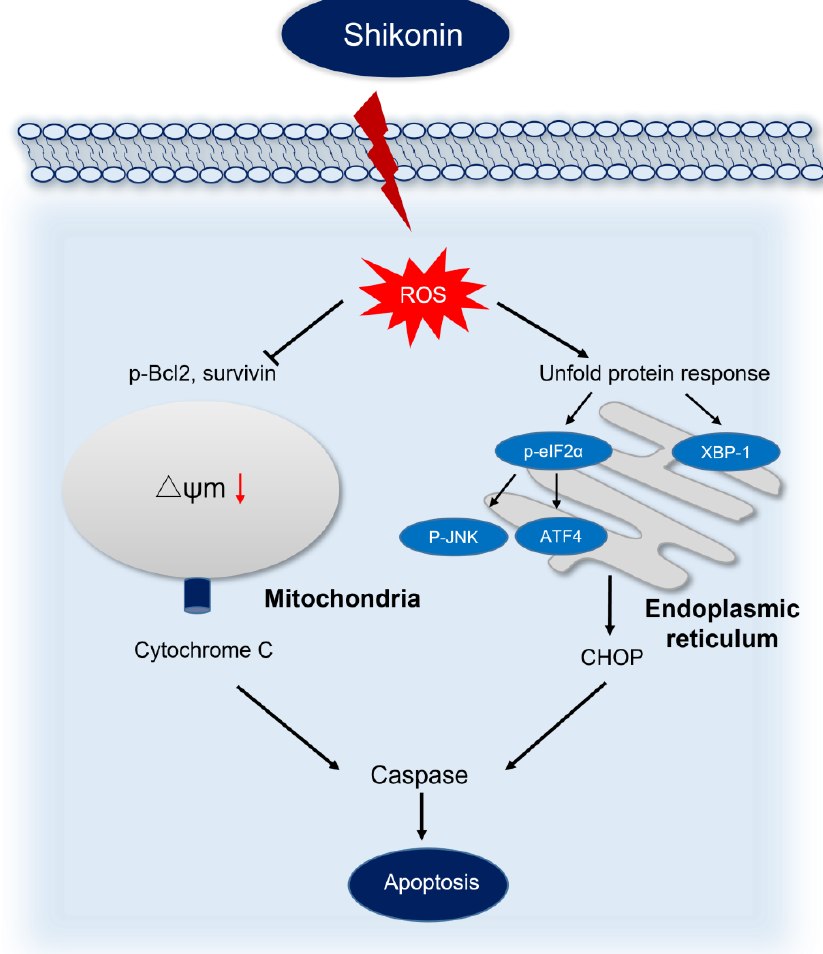
Figure 7. The proposed model of SHK-induced apoptosis. SHK-induced ROS accumulation causes mitochondria depolarization and release of cytochrome c. Separately, ROS activates ER stress markers leading to apoptosis.